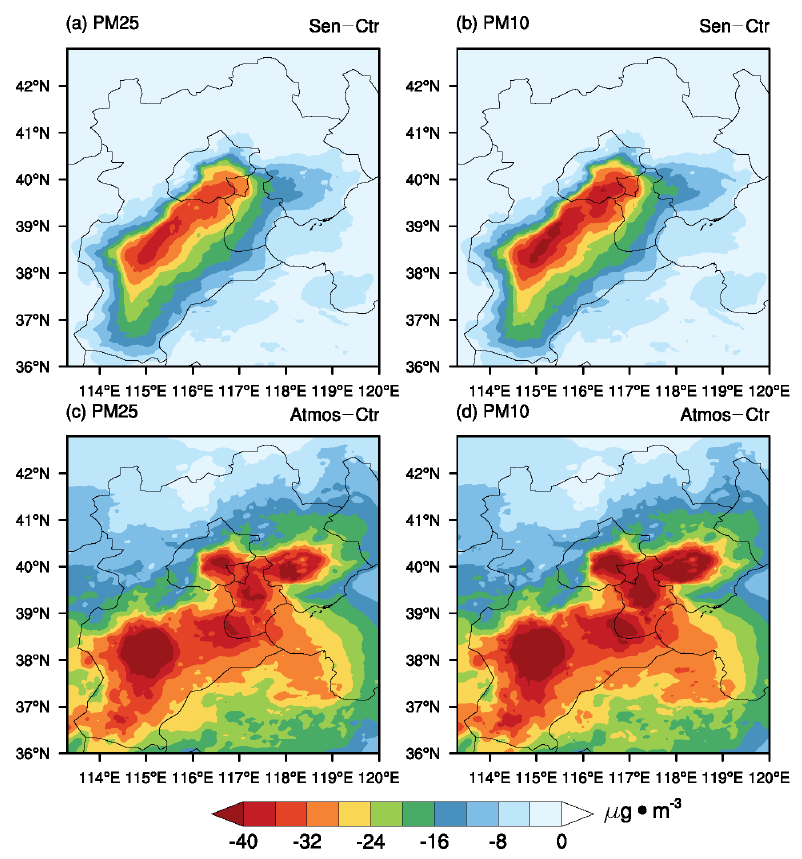
Figure 6. The spatial distribution of ( a , c ) PM 2 . 5 and ( b , d ) PM 10 (units: μ g/m 3 ) based on Base case and its difference with Sen_coal ( a , b ) and Sen_2019 cases ( c , d ). and its difference with Sen_coal ( a , b ) and Sen_2019 cases ( c , d